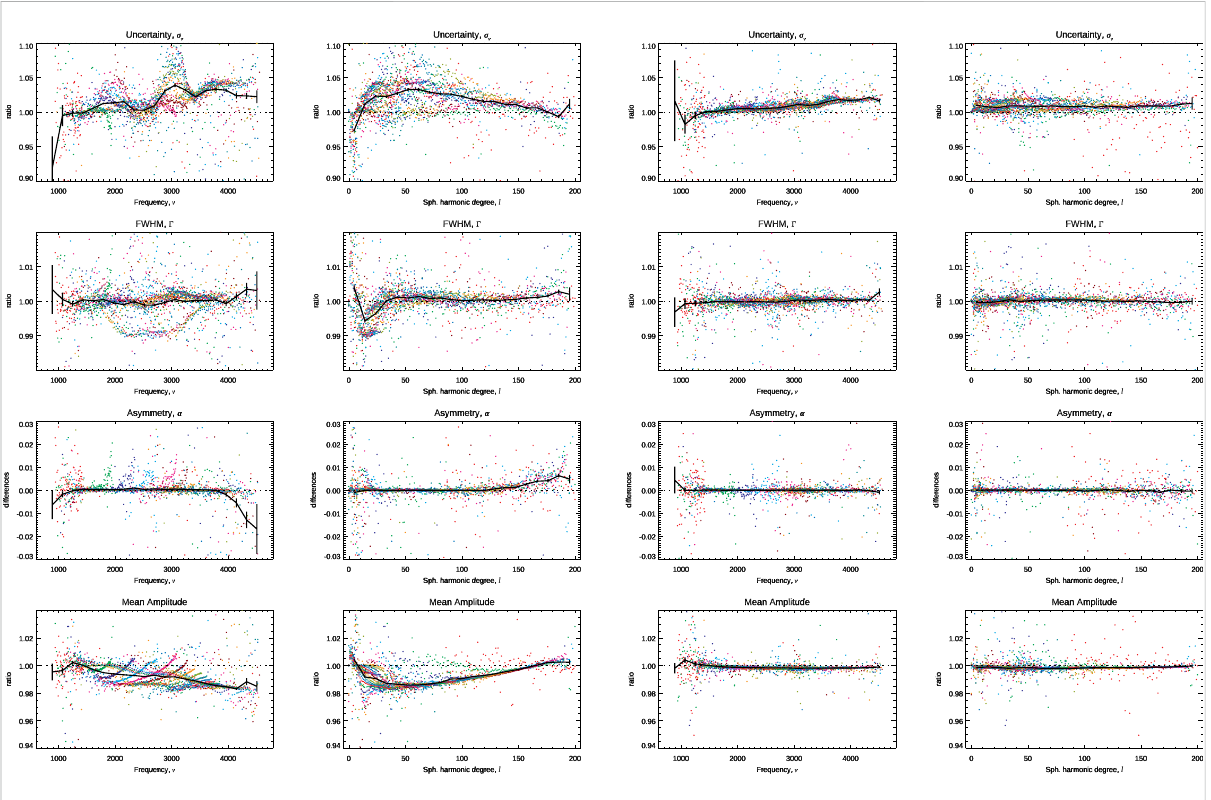
FIGURE 4 Comparison of multiplets ’ characteristics when fi tting using different leakage matrices. The eight panels on the left compare the results using the JS B o (cid:3) 0 leakage matrix to the SGK B o (cid:3) 0 leakage matrix, including the PSF; the eight panels on the right compare the results using the SGK B o (cid:3) a B o (cid:3) 0 leakage matrix, including the 2 leakage matrix to the SGK